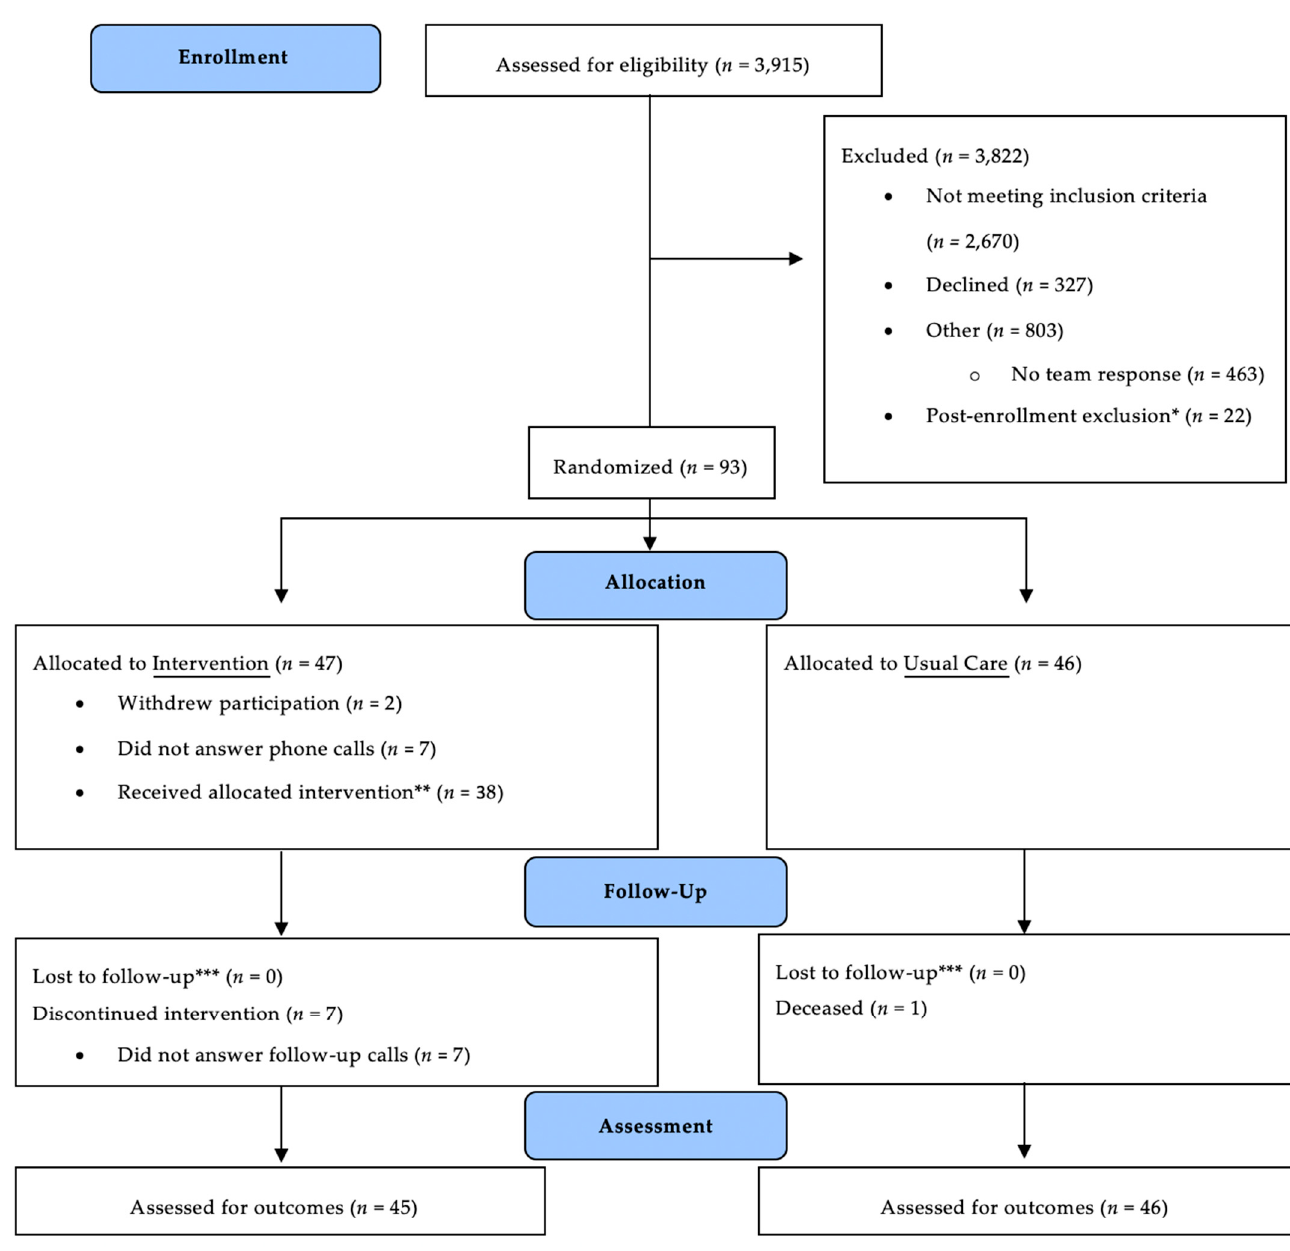
Figure 1. Flow of patients in trial. * Post-enrollment exclusion criteria were transfer to another hospital or subacute facility, discharge to hospice or a long-term care facility, signing out against medical advice, or inpatient death; ** Subject received education, adjustment of diabetes therapy upon discharge, and at least 1 follow-up phone call; *** Electronic health record used for follow-up if subject could not be contacted.